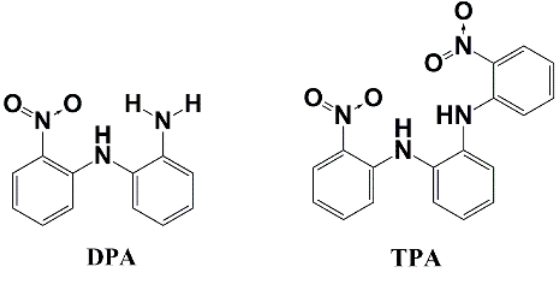
Figure 1. Structure of ionophores.